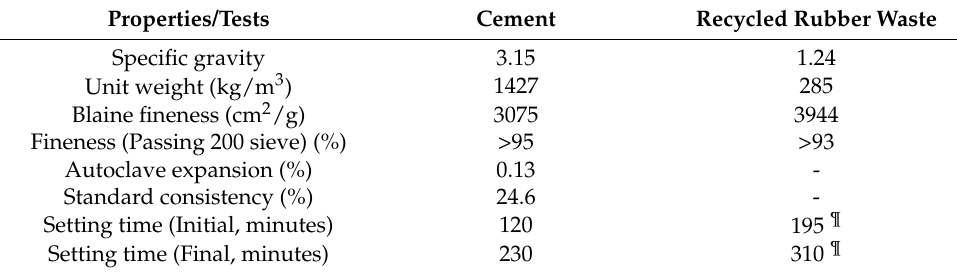
Table 5. Physical properties of cement and recycled rubber waste.